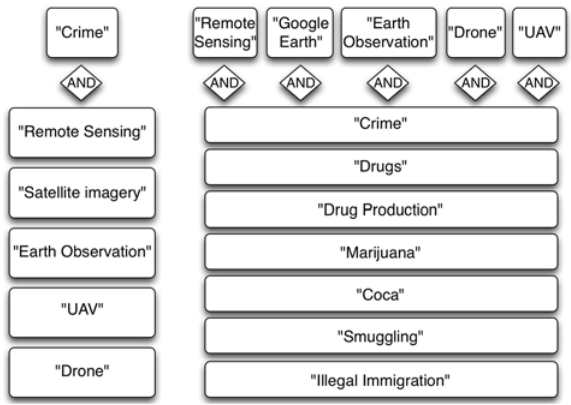
Figure 2. Search terms, phrases and combinations thereof used for the literature